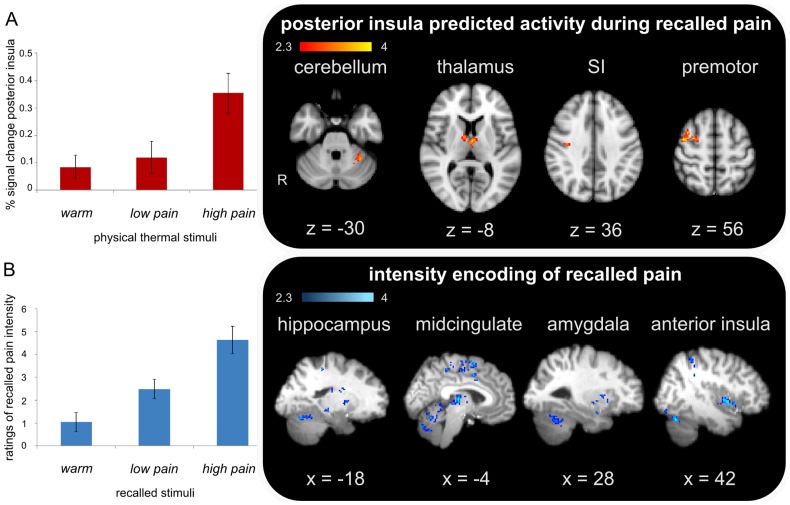
Intensity and recalled pain.A) Linking nociceptive intensity and therefore posterior insula activity during physical pain with neural activation during subsequent recall. Left: graphical summary of group mean parameter estimates (PE) of percent signal change in posterior insula during high physical pain. Error bars represent standard error. Right: predicted activity during recalled high pain incorporating individual PEs as a regressor. See Table 6 for further details of MNI coordinates. B) Intensity coding during recalled pain. Left: graphical summary of recalled intensity ratings across conditions of imagined stimuli. Error bars represent standard error. Right: Brain regions from a whole brain search whose activity increases with increased perceived intensity of the imagined stimulus and are not seen in the similar analysis performed to explore vividness encoding. Group contrast, mixed effects, Z = 2.3; p = 0.01. See Table 7a for full list of activation with MNI coordinates.